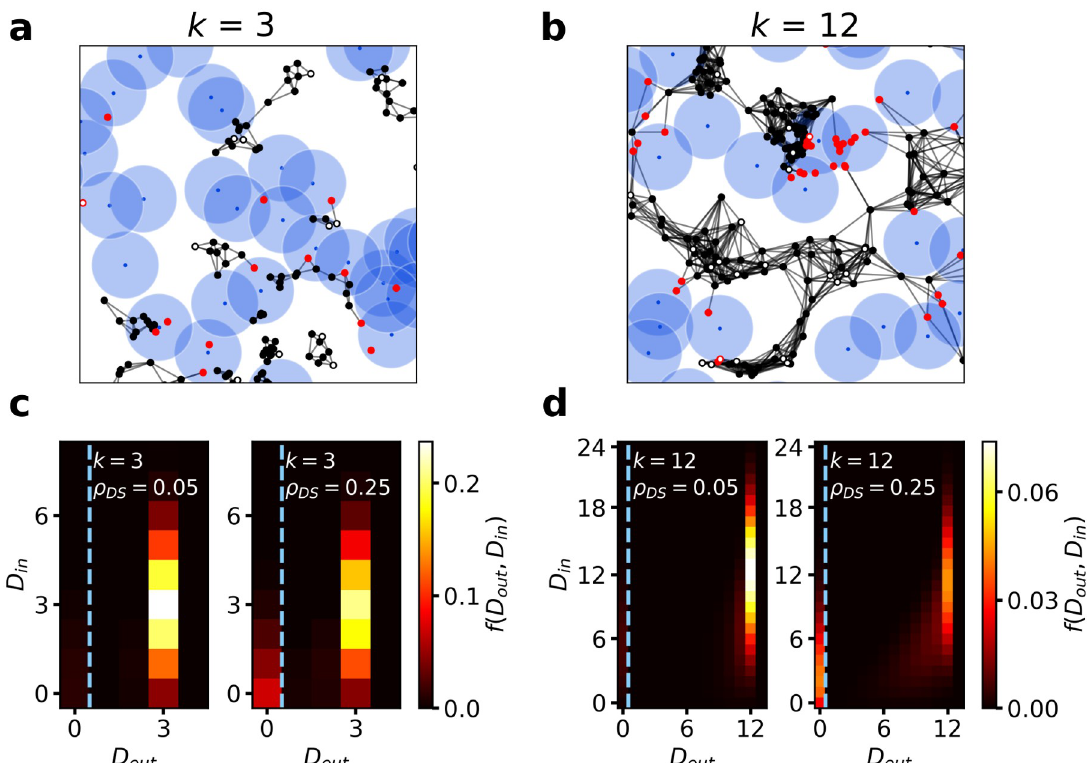
Fig 2. Emergent interaction networks. a,b : Examples of social interaction networks for k = 3 ( a ) and k = 12 ( b ) at ρ DS = 0.25. The black symbols indicate socially interacting agents, whereas the red symbols indicate agents responding to a DS. The lines indicate the (non- directed) interaction network. Filled circles represent uninformed agents, empty circles indicate agents informed about the preferred direction of migration. The DS positions shown by blue dots, are surrounded by a disc-like repulsion zones (light blue). For clarity, only a portion of the respective simulation box is represented here, see S1 Fig. for the full snapshots. c,d : In-out degree distributions for the emergent social interaction networks for low attention limit k = 3 ( c ) and high attention limit k = 12 ( d ) at low and high DS densities ( ρ DS = 0.05, and ρ = 0.25). The vertical dashed lines are for visual guidance to distinguish the subpopulations with D = 0 corresponding to DS out agents responding to DSs (left of the vertical line). At high density of DSs this distribution is clearly bimodal with two peaks at D out = 0 = k . By increasing DS density number of agents with D = 0 increases. These agents have a lower in-degree compared to non- and D out out responders, which contributes to the self-isolation of the collective from environmental cues at low k values. For all panels: R inf =